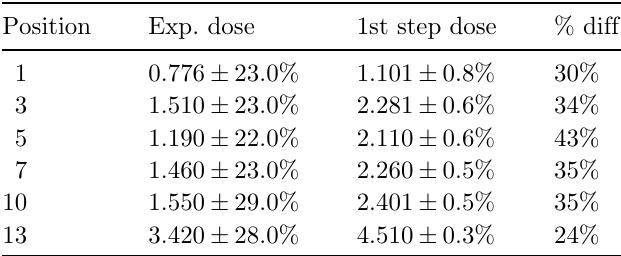
Table 1. Experimental and 1st step simulated doses in 10 (cid:4) 14 Gy/pot, in different positions at CHARM, cp_0000 con fi guration.